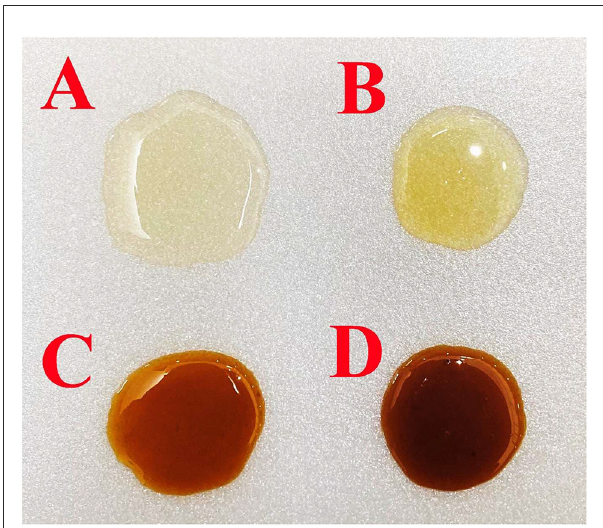
FIGURE2 Melipona beecheii (A) , Scaptotrigona pectoralis (B) , Plebeia jatiformis (C) , and Plebeia llorentei (D) honey samples taken from the same honeybee farm.